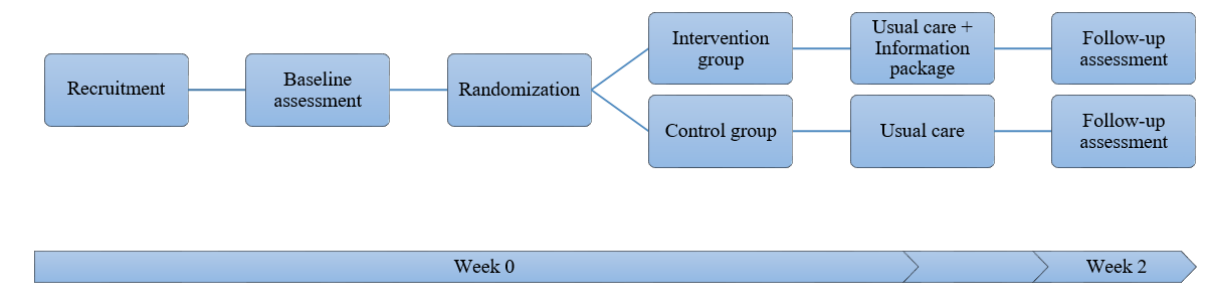
Figure 1. Flow chart of study